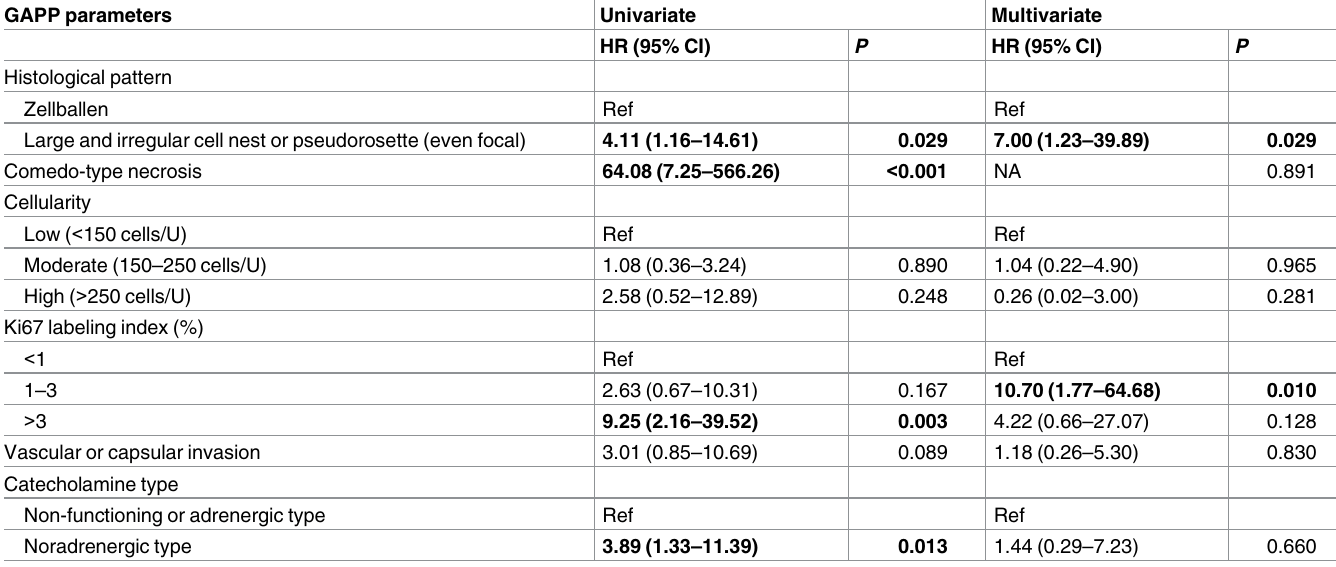
Table 4. Association of the individual parameters of the GAPP at the initial operation with occurrence of metastasis. GAPP parameters